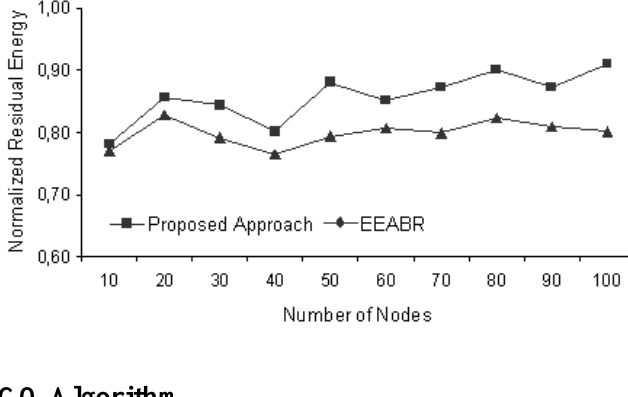
Figure 7. Average residual energy after 256 packets are received.